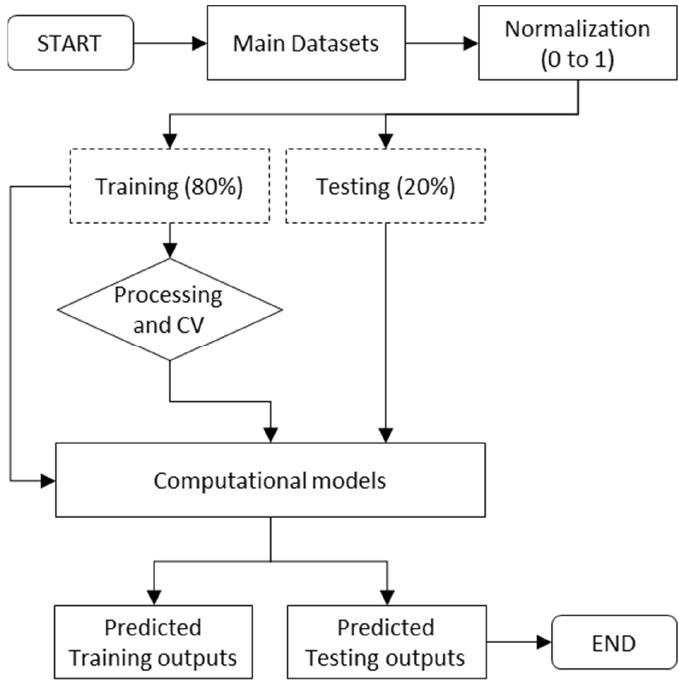
Figure 5. Steps for model construction and validation.